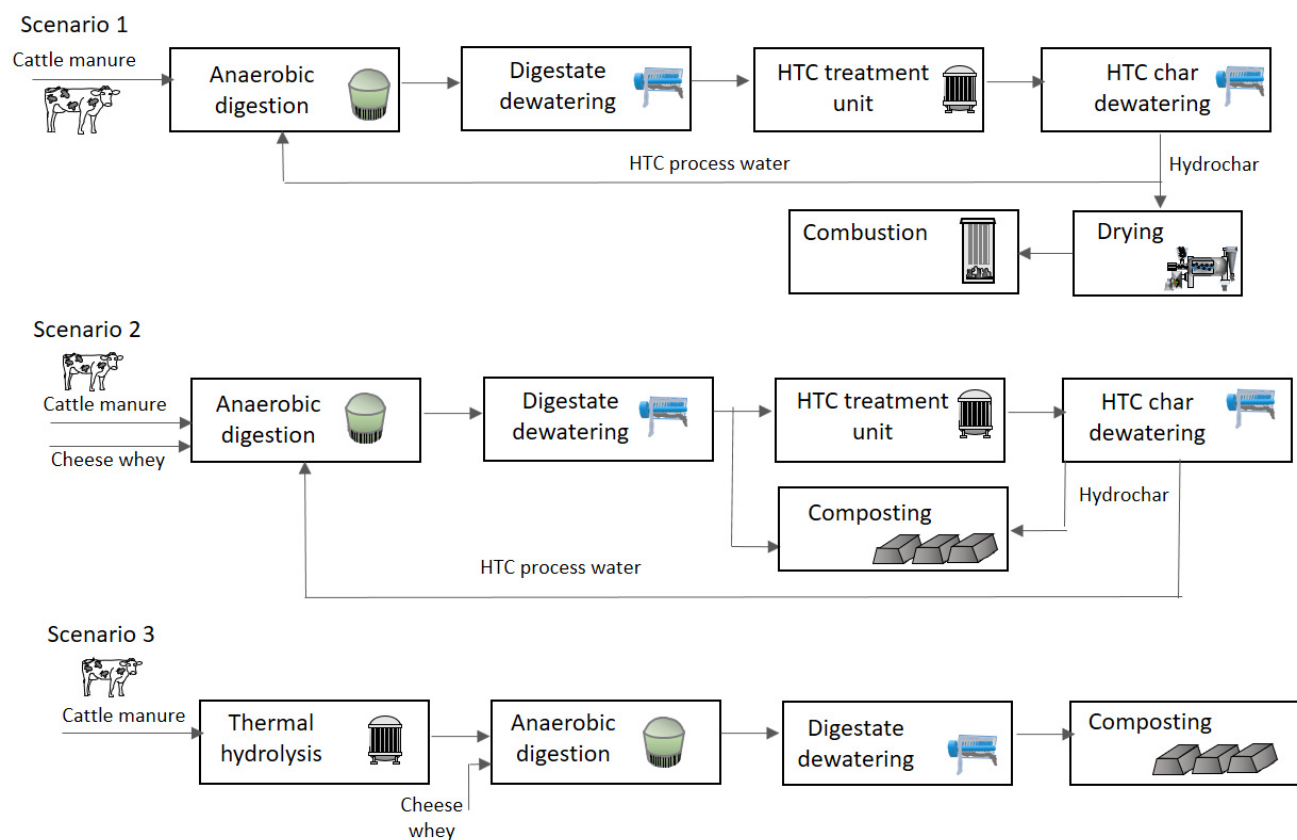
Figure 1. Representation of the three different scenarios showing the main process stages. Cattle manure is the primary substrate, with cheese whey added as co-substrate.